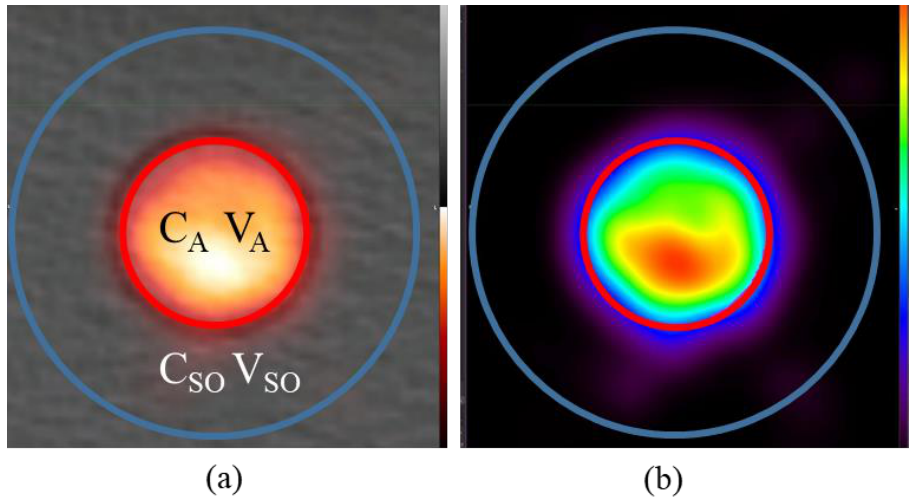
Figure 1. Visualization of PET PVE in the presented phantom, specifically the “spill-out” effect from the hot to cold region. ( a ) The true artery ROI (outlined in red) as contoured in CT is listed as having image-derived concentration C A and volume V A while the large region (labelled C SO /V SO , outlined in blue) is comprised of the true hot region plus the “spill-out” region. ( b ) Visualization of the “spill-out” from the V A region into V SO shown on the PET only.